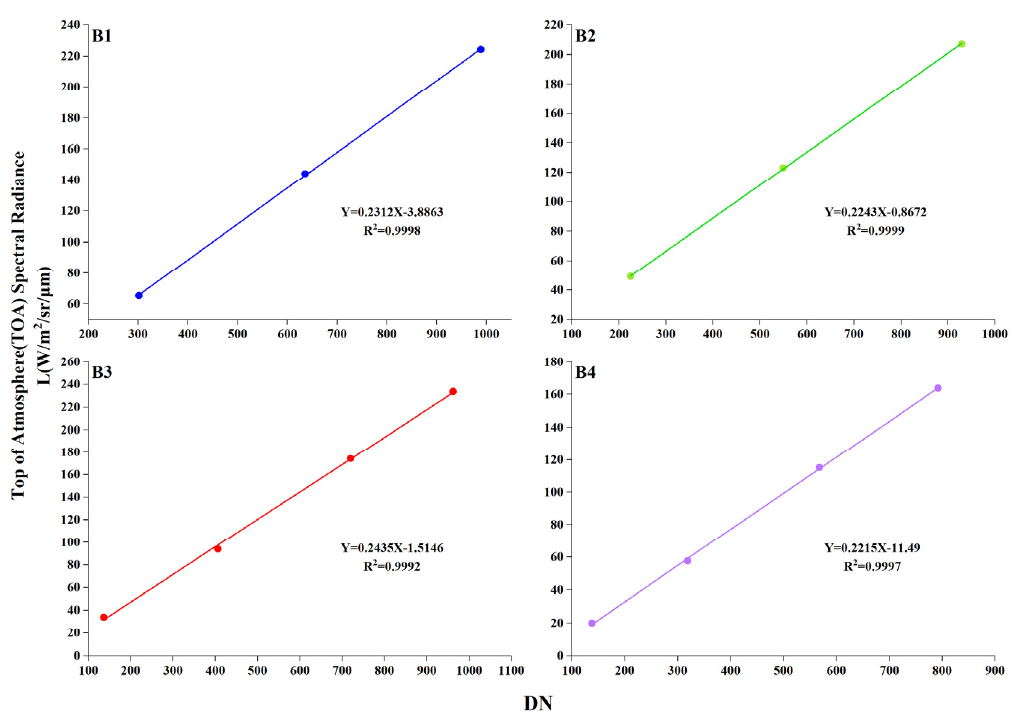
Figure 8. Calibration results using irradiance-based method on 3 July 2018.